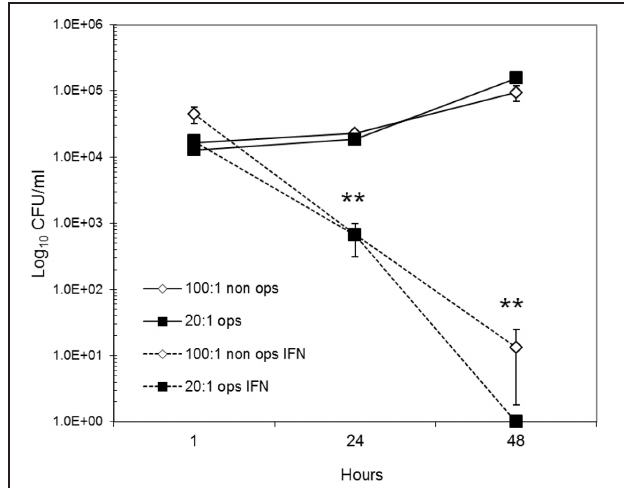
FIGURE A2 | Effect of IFN- γ treatment on Brucella infected Raw264.7 cells. Pretreatment of Raw264.7 cells with 50ug/ul of IFN- γ 24h prior to infection with B. abortus induces an anti-bacterial response that increases Brucella killing at 24h p.i. ( T = 1), continuing through 48h p.i. ( T = 2). Magnitude of anti- Brucella effect was equal among opsonized and non-opsonized Brucella . Similarly, bacterial survival at 24h p.i., and replication detected at 48h were the same between opsonized and non-opsonized bacteria infected at normalized MOI’s ( Figure 1 ). Results represent the averages and standard deviation from six replicate wells for each condition and time point. Statistical analysis was performed using non-paired Student’s t